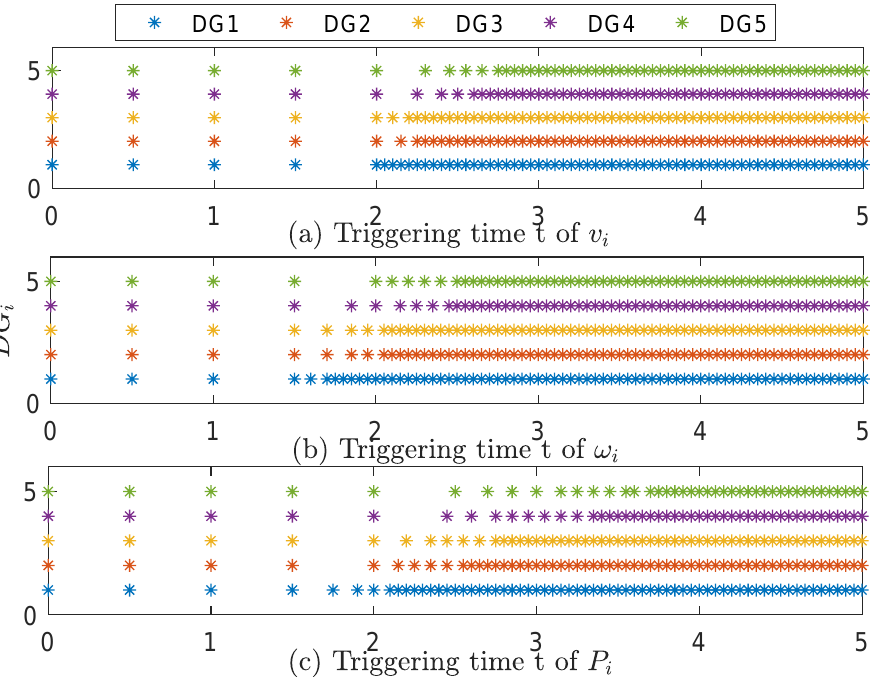
Figure 6. The self-triggered time of the voltage, frequency and power, respectively: ( a ) the voltage v i ; ( b ) the frequency ω i ; ( c ) the power P i